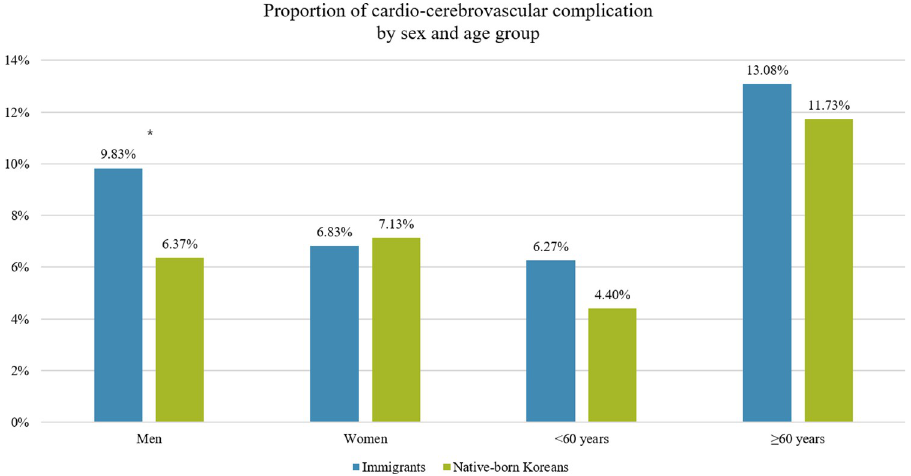
Fig 2. Proportion of cardio-cerebrovascular complications by sex and age group in both immigrants and native- born Koreans.